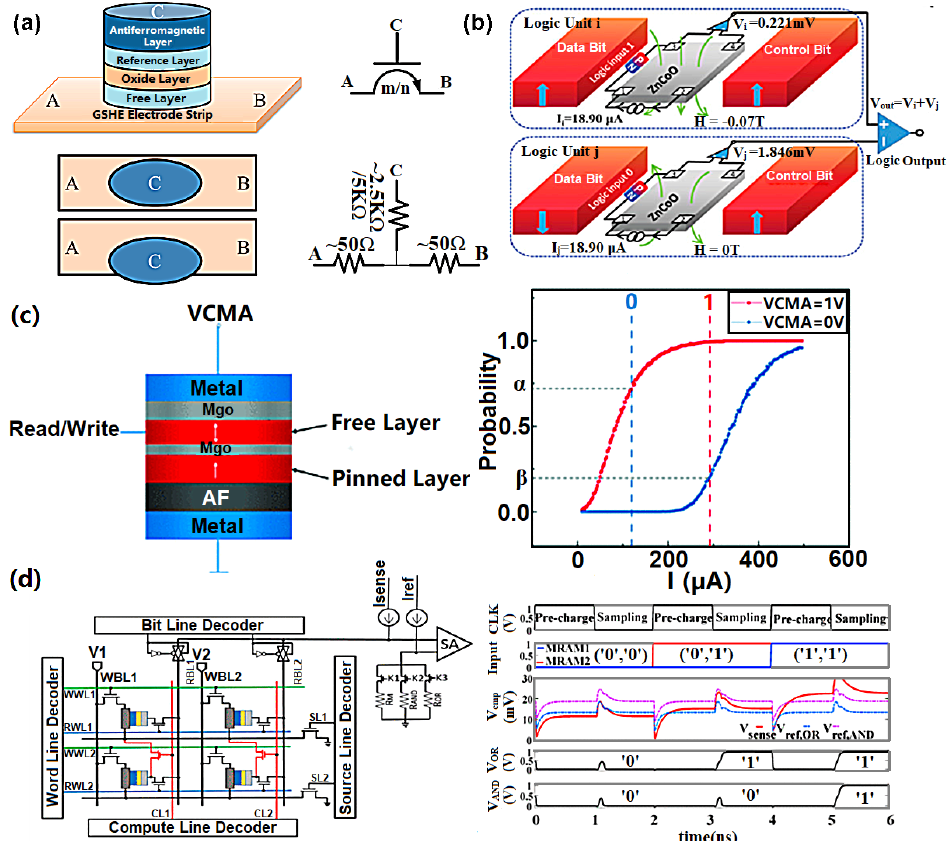
Figure 7. ( a ) The structure of a GSHE MTJ (Giant Spin-Hall Effect MTJ) (3D view (top left), top-down view (bottom left), device symbols (top right), and equivalence circuit (bottom right)); ( b ) schematic of the two-input logic function (NOR) in a DEMR (device diode-enhanced magnetoresistance); ( c ) device structure of the voltage-controlled MTJ (left) and its corresponding voltage and current signals to map Boolean logic ‘ 0 ’ and ‘ 1 ’ (right); ( d ) proposed SOT-MRAM based